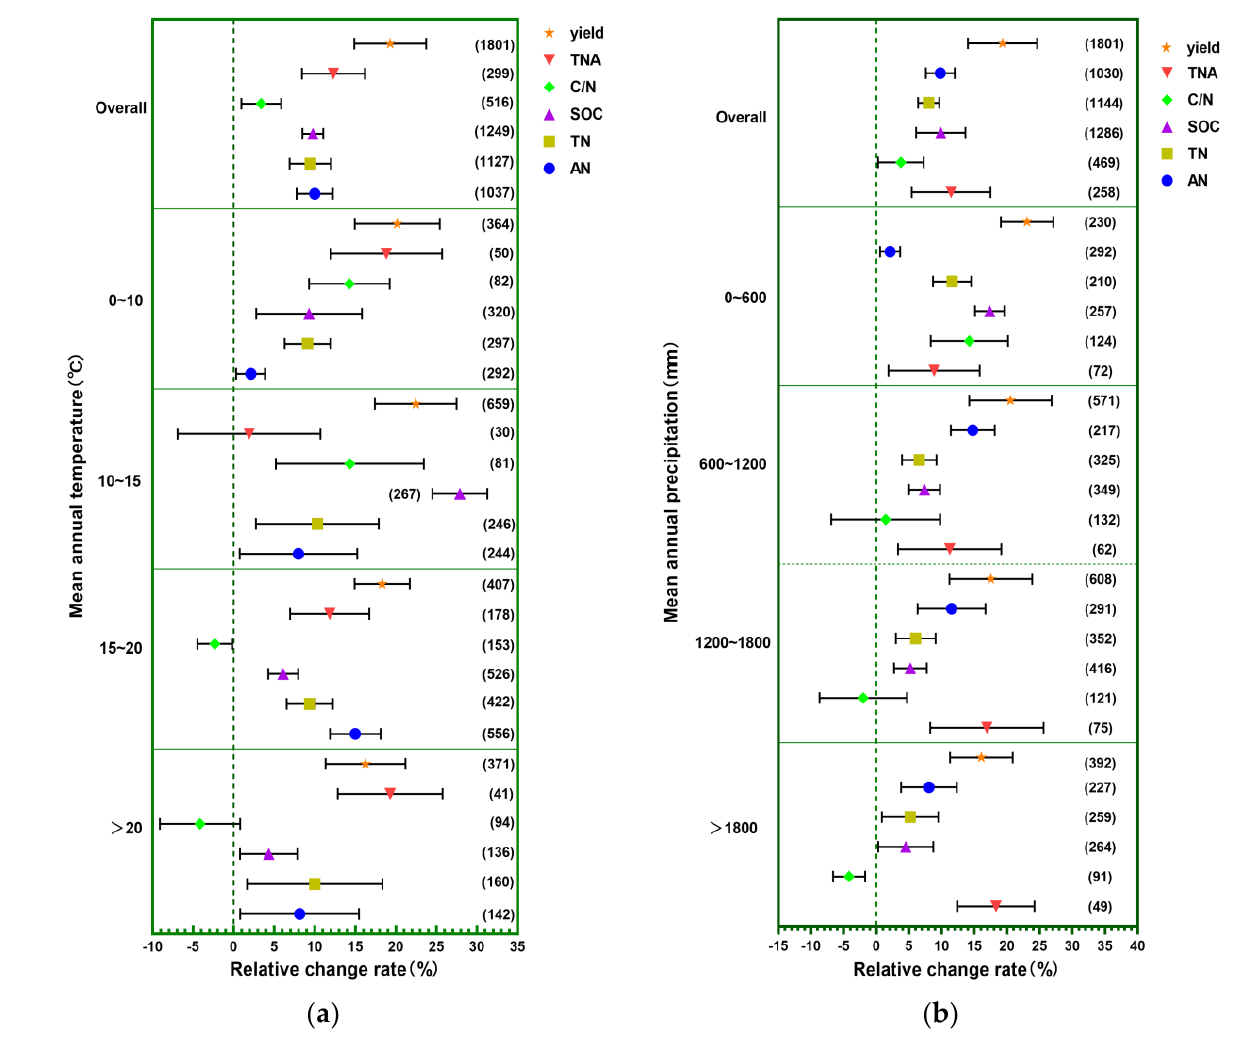
Figure 4. Relative change rates for different temperature ( a ) and precipitation ( b ) conditions. De- scription of symbols: AN, soil alkali−hydrolysable nitrogen; TN, soil total nitrogen; SOC, soil organic matter; C:N, the soil carbon to nitrogen ratio; and TNA, total N accumulation by rice. Numbers in parentheses represent the effect value (lnR).